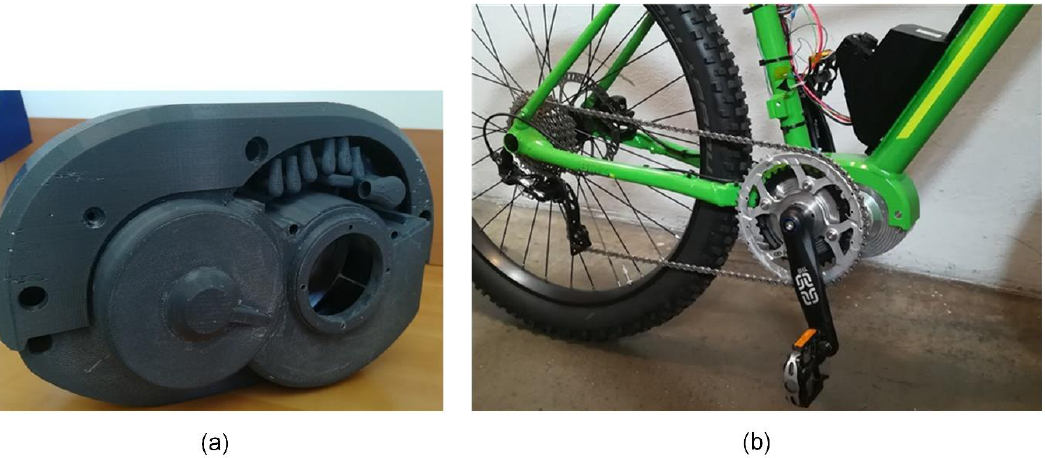
Figure 5. Prototype A3: ( a ) 3D printed prototype to test the suitability of a connector set; ( b ) functional prototype tested on a bicycle.